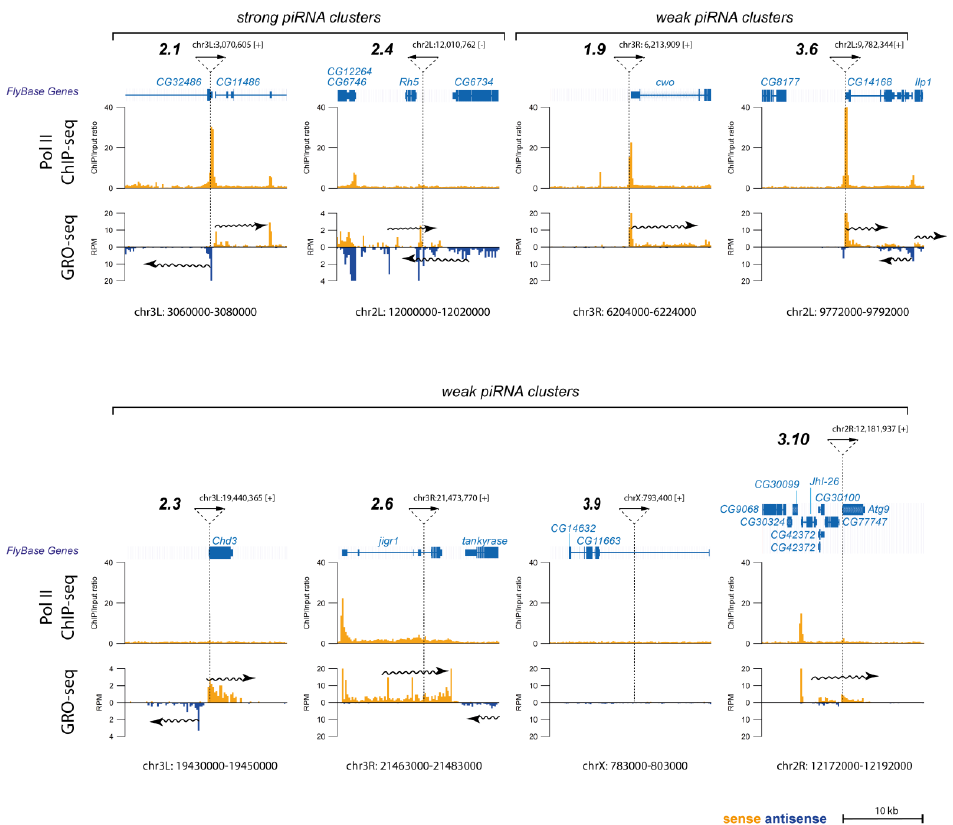
Figure 7. Transcriptional status of I-TG transgene insertion loci before insertion of the transgenes. PolII ChIP-seq data are shown as a ChIP / input ratio. GRO-seq reads mapping to the genomic loci of I-TG transgene insertions are shown in RPM. The pictures were generated using the UCSC Genome Browser. Dotted lines indicate the insertion sites of the I-TG s. Plain arrows indicate the genomic orientation of transgenes; wavy arrows show the direction of transcription in a